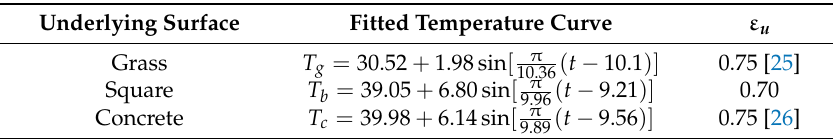
Table 7. Common underlying surfaces in cities.